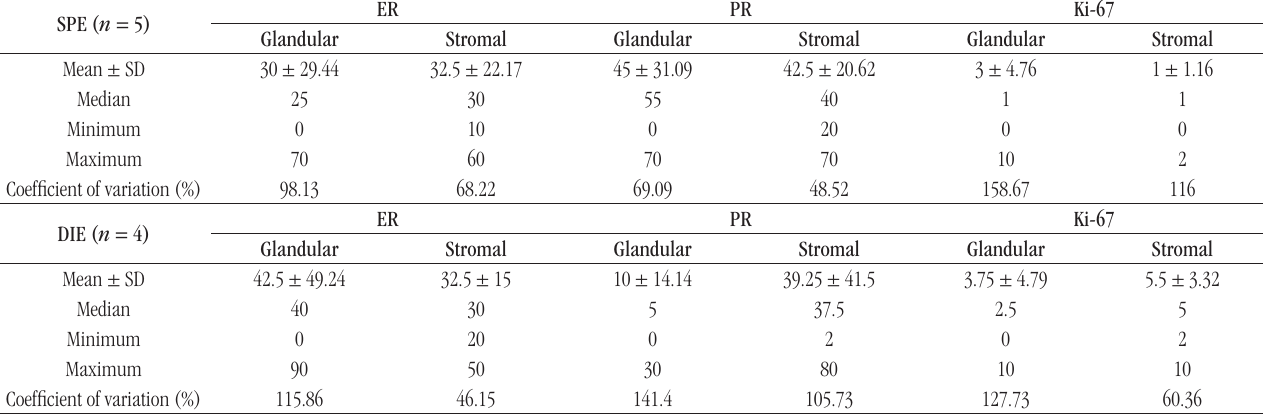
TABLE – Percentage descriptive analysis of variables ER, PR, and Ki-67 in SPE and DIE in glandular and stromal